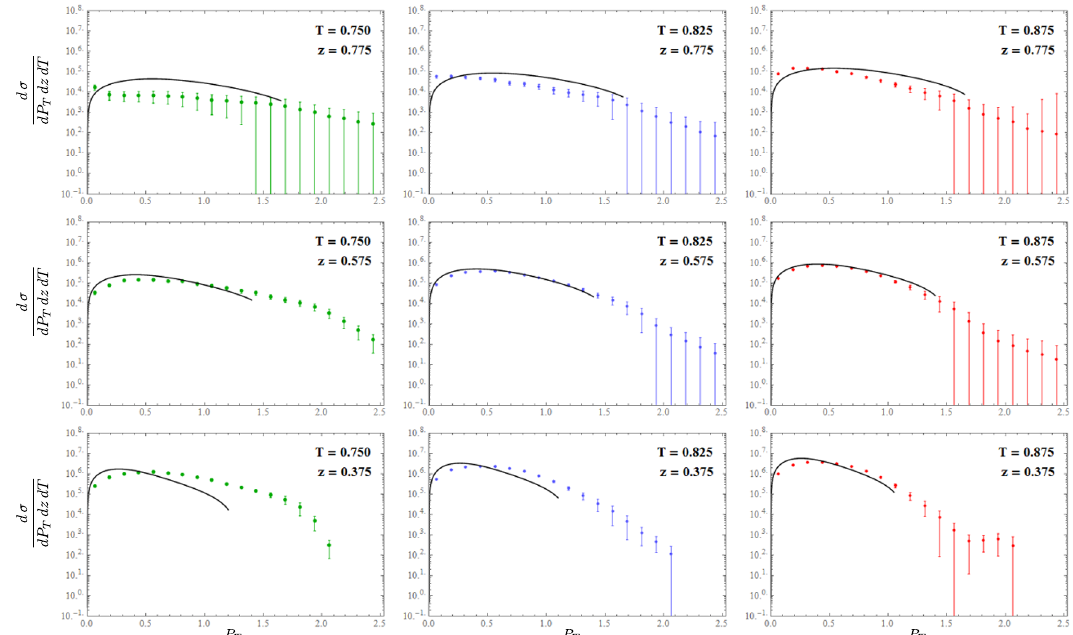
Figure 7 . e + e − → hX cross section computed to NLO and NLL accuracy, corresponding to 9 of the bins measured by the BELLE Collaboration. The value of z in each column of panels: the upper row of panels corresponds to z z h = 0 . 575 , the lowest row to z h = 0 . 775 . Moving left to right, instead, corresponds to increasing values of thrust. In the leftmost column of panels T = 0 . 750 , in the central column T = 0 . 825 , in the rightmost column T = 0 . 875 . Uncertainty bands are not shown as no fit is involved in this computation. The collinear fragmentation functions used for the implementation of eq. (4.5) are the NNFF10_NLO reference set [38] for π + production. Uncertainties due to the errors on the collinear fragmentation functions are not